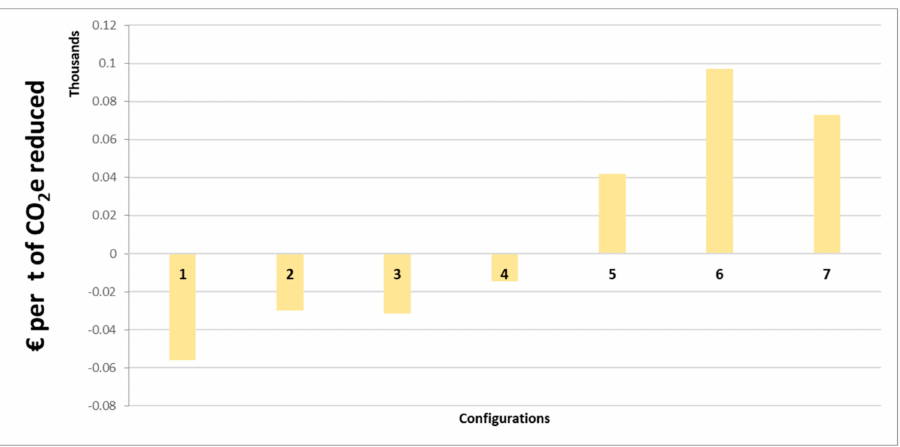
Figure 7. Cost-benefit analysis results for the cruise ship